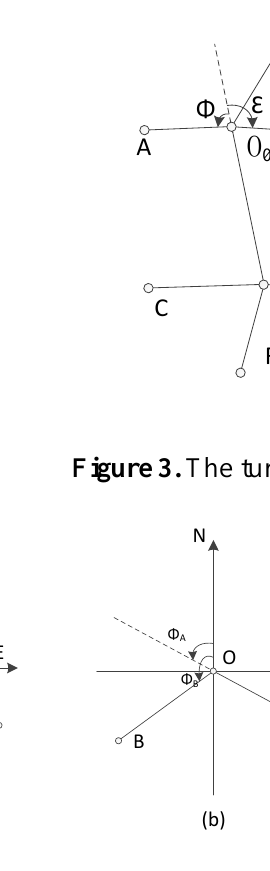
Figure 4. The calculation of the value of turn angles: ( a ) case a, ( b ) case b ( c ) case c and ( d ) case